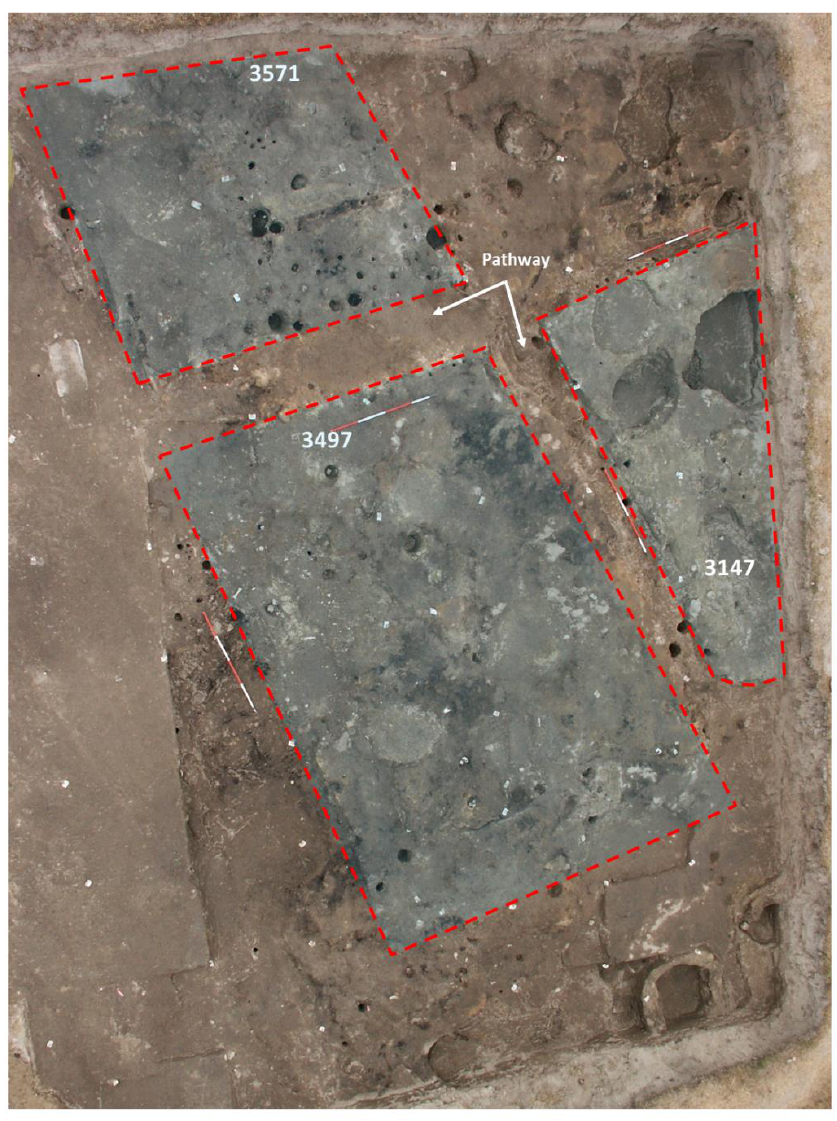
Figure 10. Burnt surface of house ID 3497 (and position of the neighboring